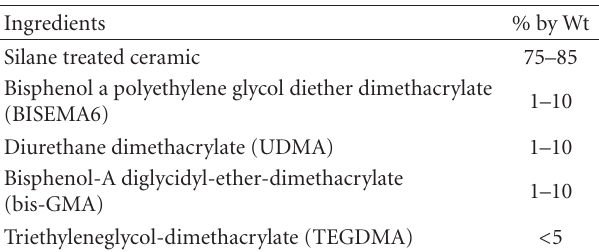
Table 1: Ingredients of composite Filtek-Z250 (3M, ESPE, St. Paul, MN, USA).